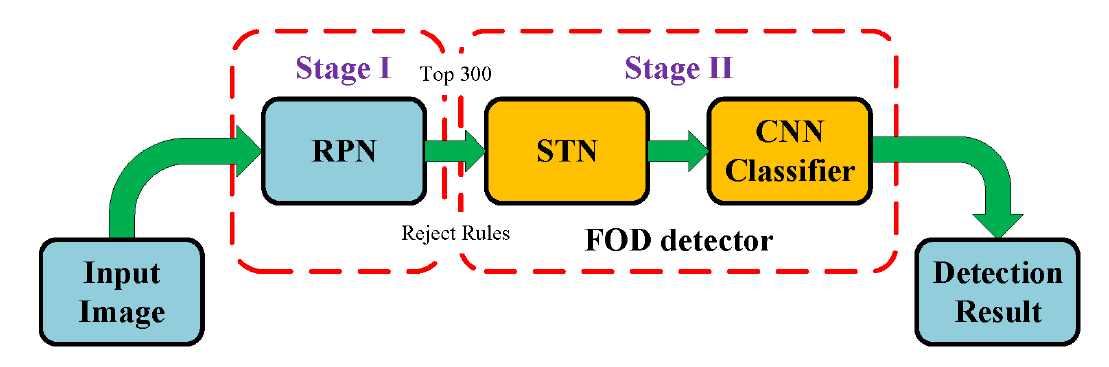
Figure 1. The framework of the FOD detection in this